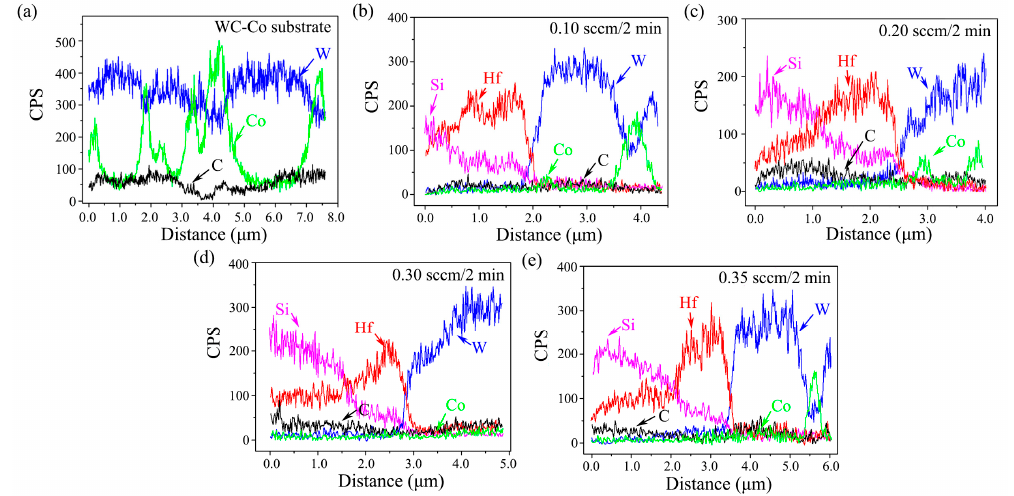
Figure 7. Typical EDS patterns of ( a ) WC-Co substrate and HfC-SiC mixed bi-interlayers prepared with TMS flow rate increment of ( b ) 0.10 sccm / 2 min, ( c ) 0.20 sccm / 2 min, ( d ) 0.30 sccm / 2 min, and ( e ) 0.35 sccm / 2 min.